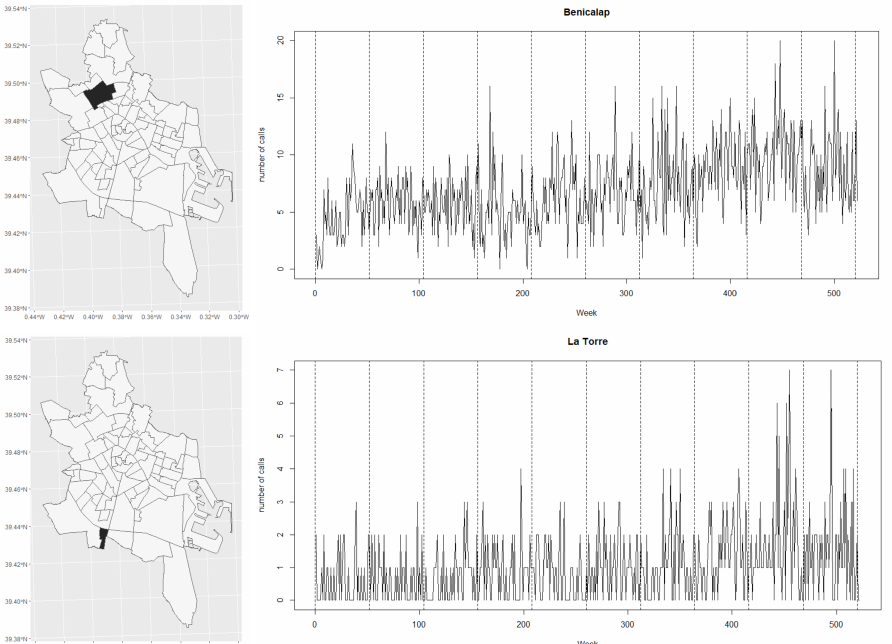
Figure 5. Weekly calls distribution over time at Benicalap, northern Valencia (top row), and at La Torre, southern Valencia (bottom